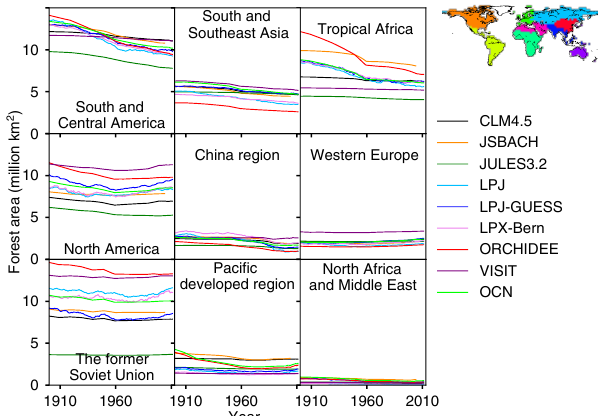
Figure 2. Temporal change in forest area from TRENDY-v2 models in each of the nine regions. Differences between models arise from their specific vegetation maps and rules through which natural PFTs are chosen to give land to